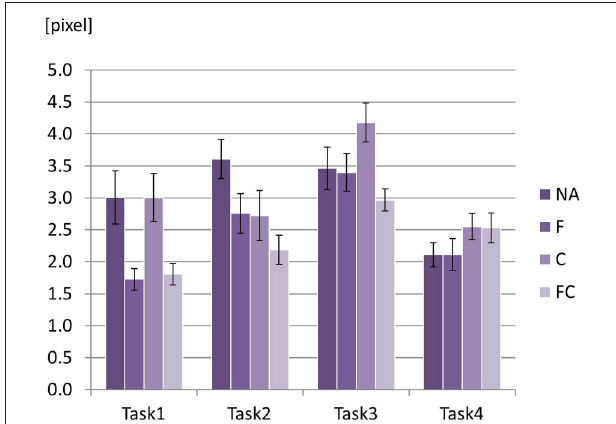
FIGURE 13 | Mean values for M3 with two factors: four task scenarios × four augmented sensory feedback conditions. An error bar on the top of each graph represents standard